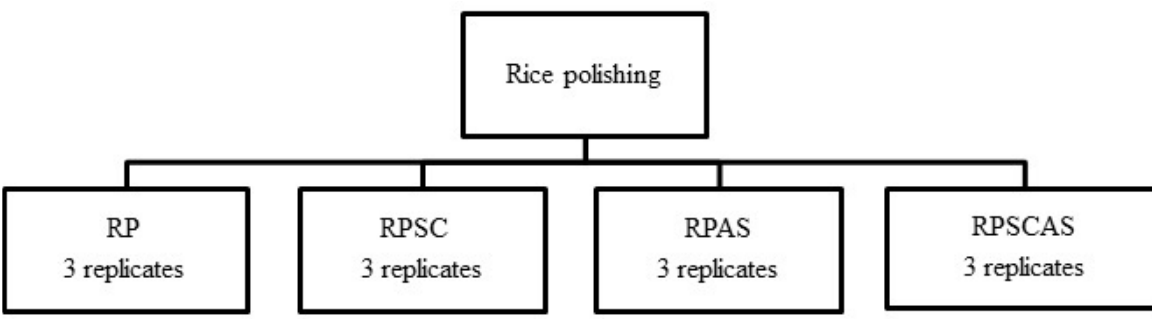
Figure 1. Flow diagram of research experiment. RP= Rice polishing,RPSC=Rice polishing plus Saccharomyces culture,RPAS=Rice polishing plus ammonium sulphate, RPSCAS=Rice polishing plus ammonium sulphate and Saccharomyces